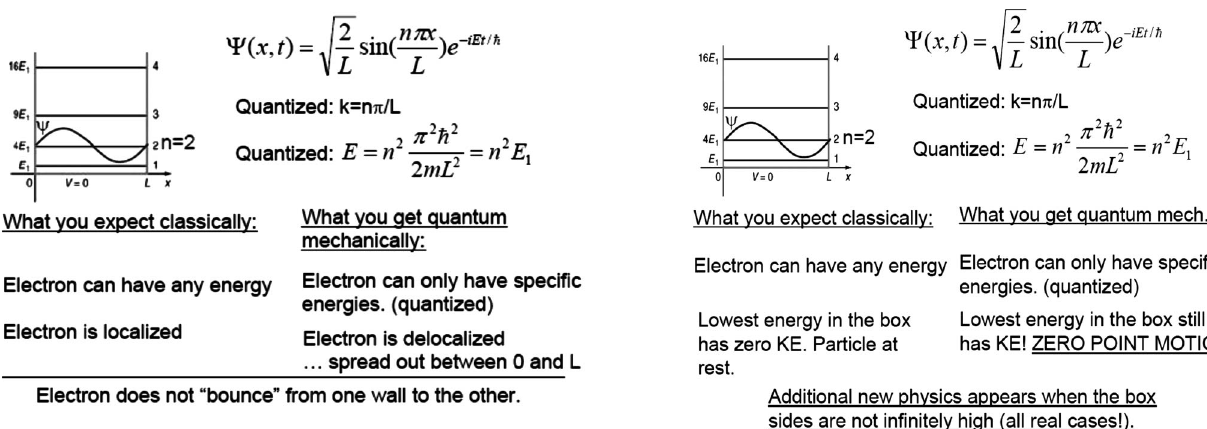
FIG. 4. A lecture slide from PHYS3A (cid:1) left, Infinite Square Well (cid:2) and one from PHYS3B (cid:1) right, Particle in a Box (cid:2)